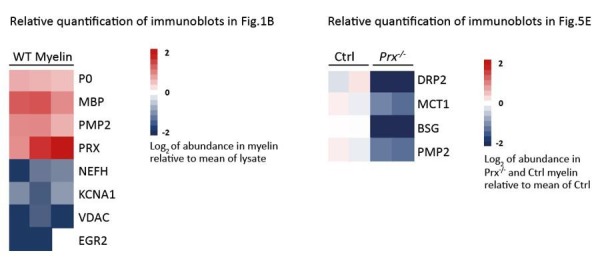
Quantification of immunoblots in Figure 1B and Figure 5E.